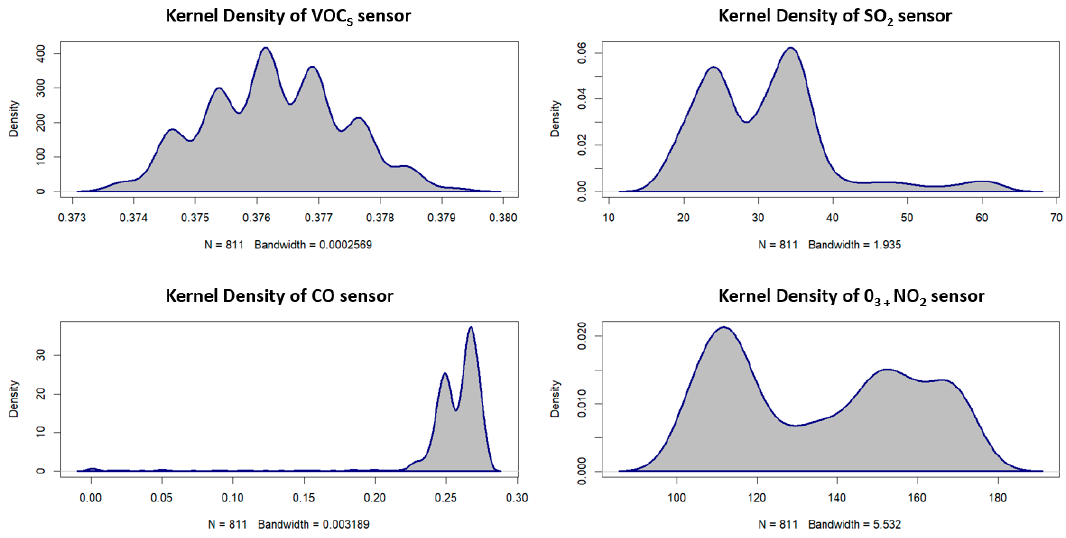
Figure A3. Kernel density for first ground measurement (H 2 S sensor, HCL sensor).